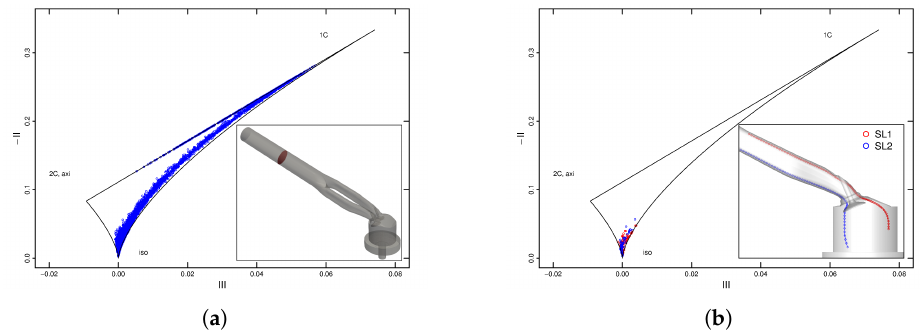
Figure 15. Anisotropy map of intake valve flow: ( a ) across the duct plane, ( b ) along the stream lines.